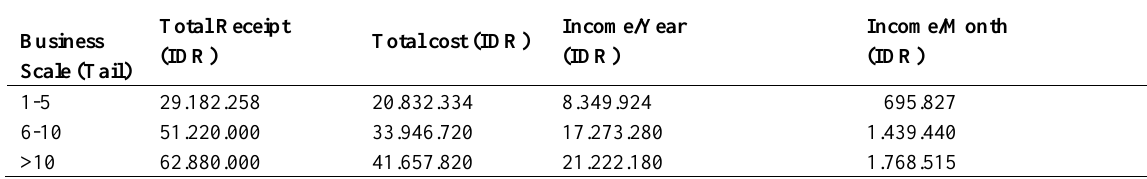
Table 4: Average Income of Bali Cattle Breeders on Different Business